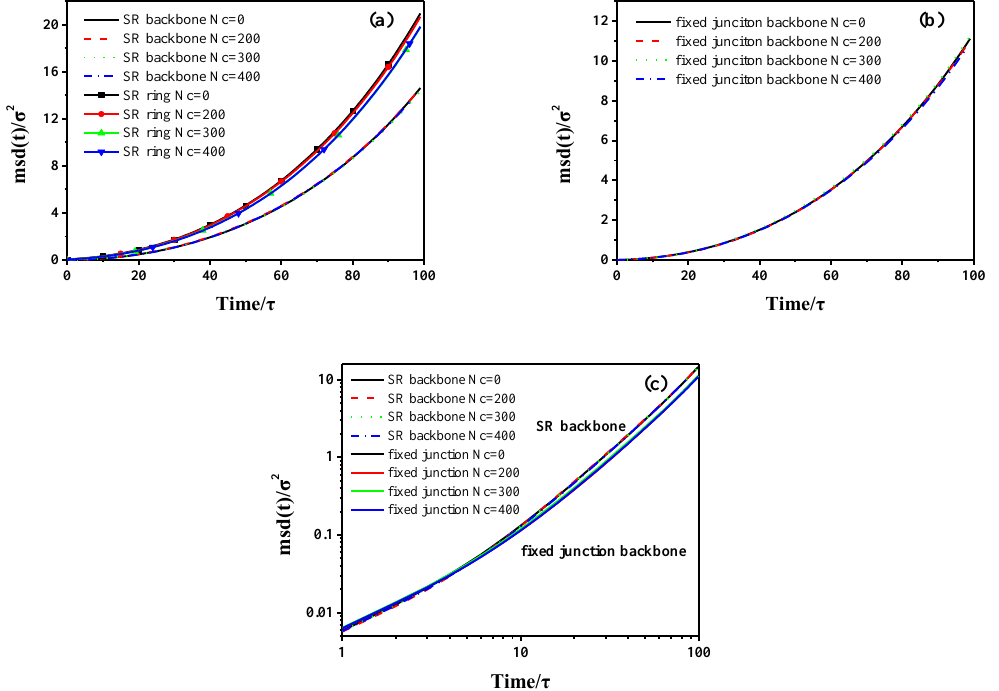
Figure 15. The mean-square displacement (MSD) of ( a ) backbone and ring in SR systems, ( b ) backbone in the fixed junction systems with different number of cross-linked bonds, and Nc during the compressive process. ( c ) The comparison of raw MSD curves of backbone in SR systems and fixed junction systems. Notice that the curves with different Nc are aligned to each other. Those curves are derived from statistical averages, and each curve consists of 100 data points.